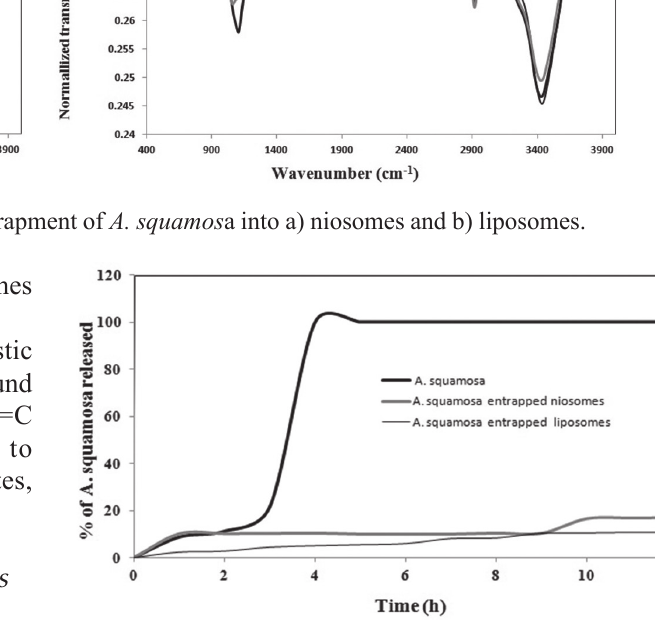
FIGURE 5 - In vitro release curves of A. squamosa from noisome and